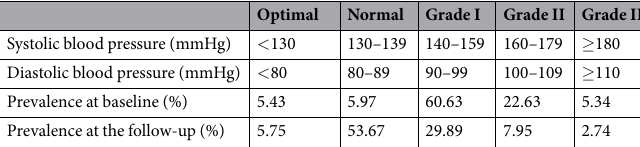
Table 1. Patient distributions according to hypertension grade.